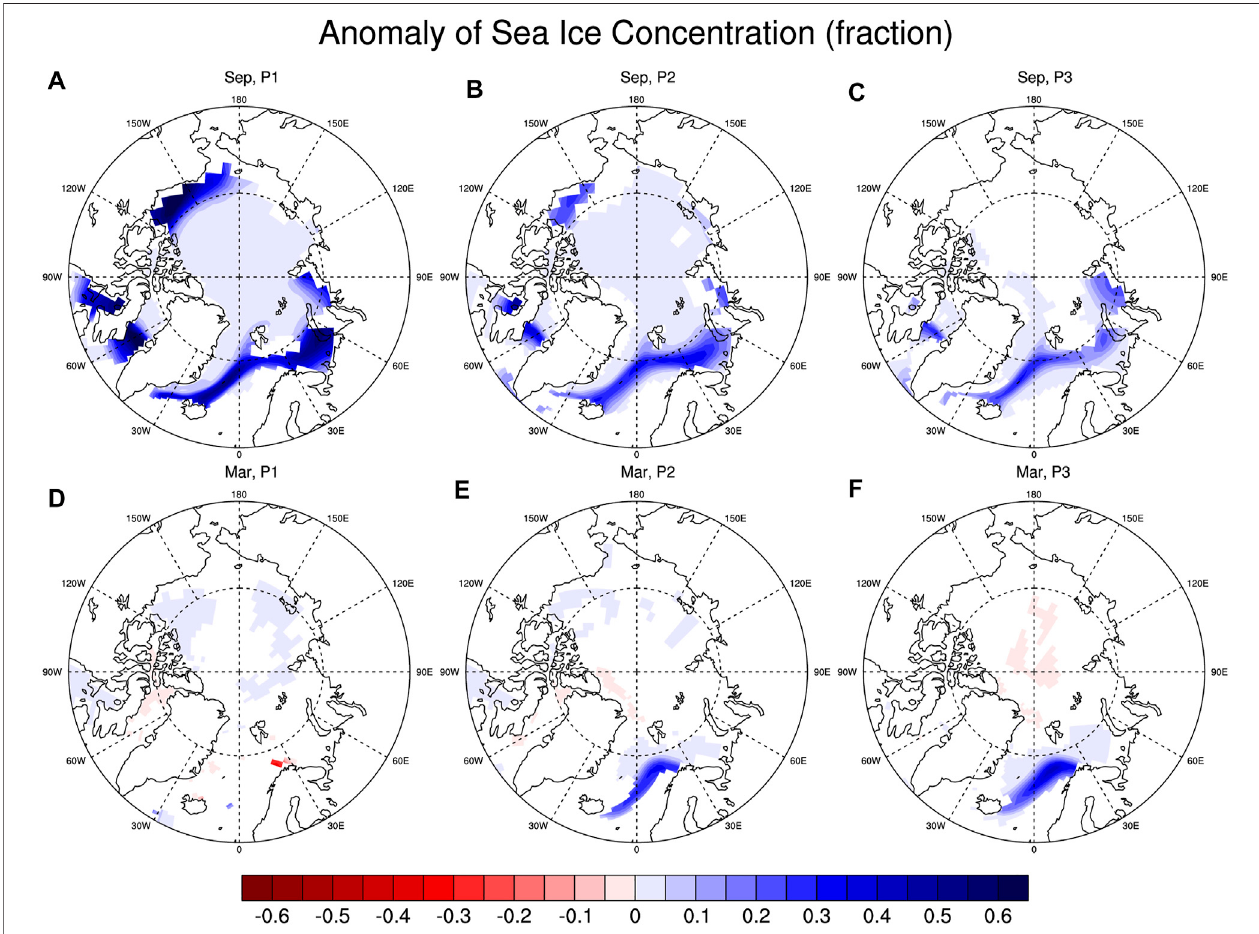
FIGURE 6 | Ensemble-mean simulated Arctic sea ice concentration (fraction) anomalies in September (top panels) and March (bottom panels) during Period-1 (A,D) , Period-2 (B,E) and Period-3 (C,F) . Only changes statistically signi fi cant at the 90% con fi dence level are shown.